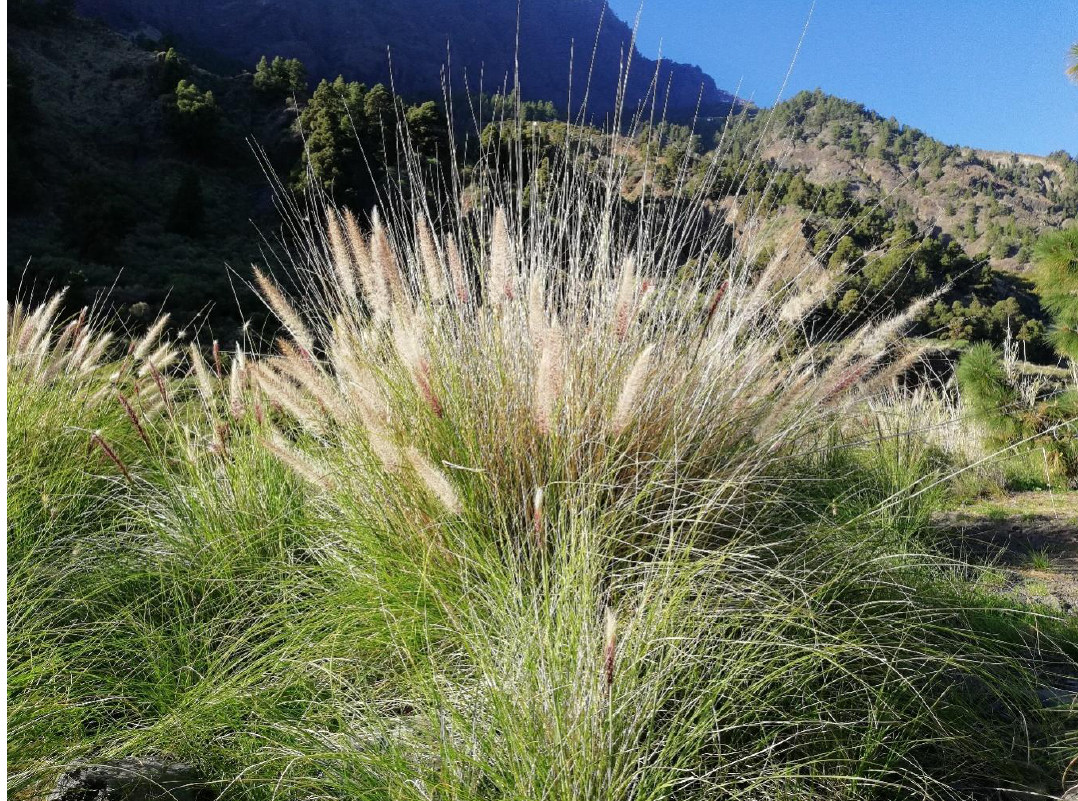
Figure 2. The Crimson fountain grass Pennisetum setaceum as an invader on La Palma.